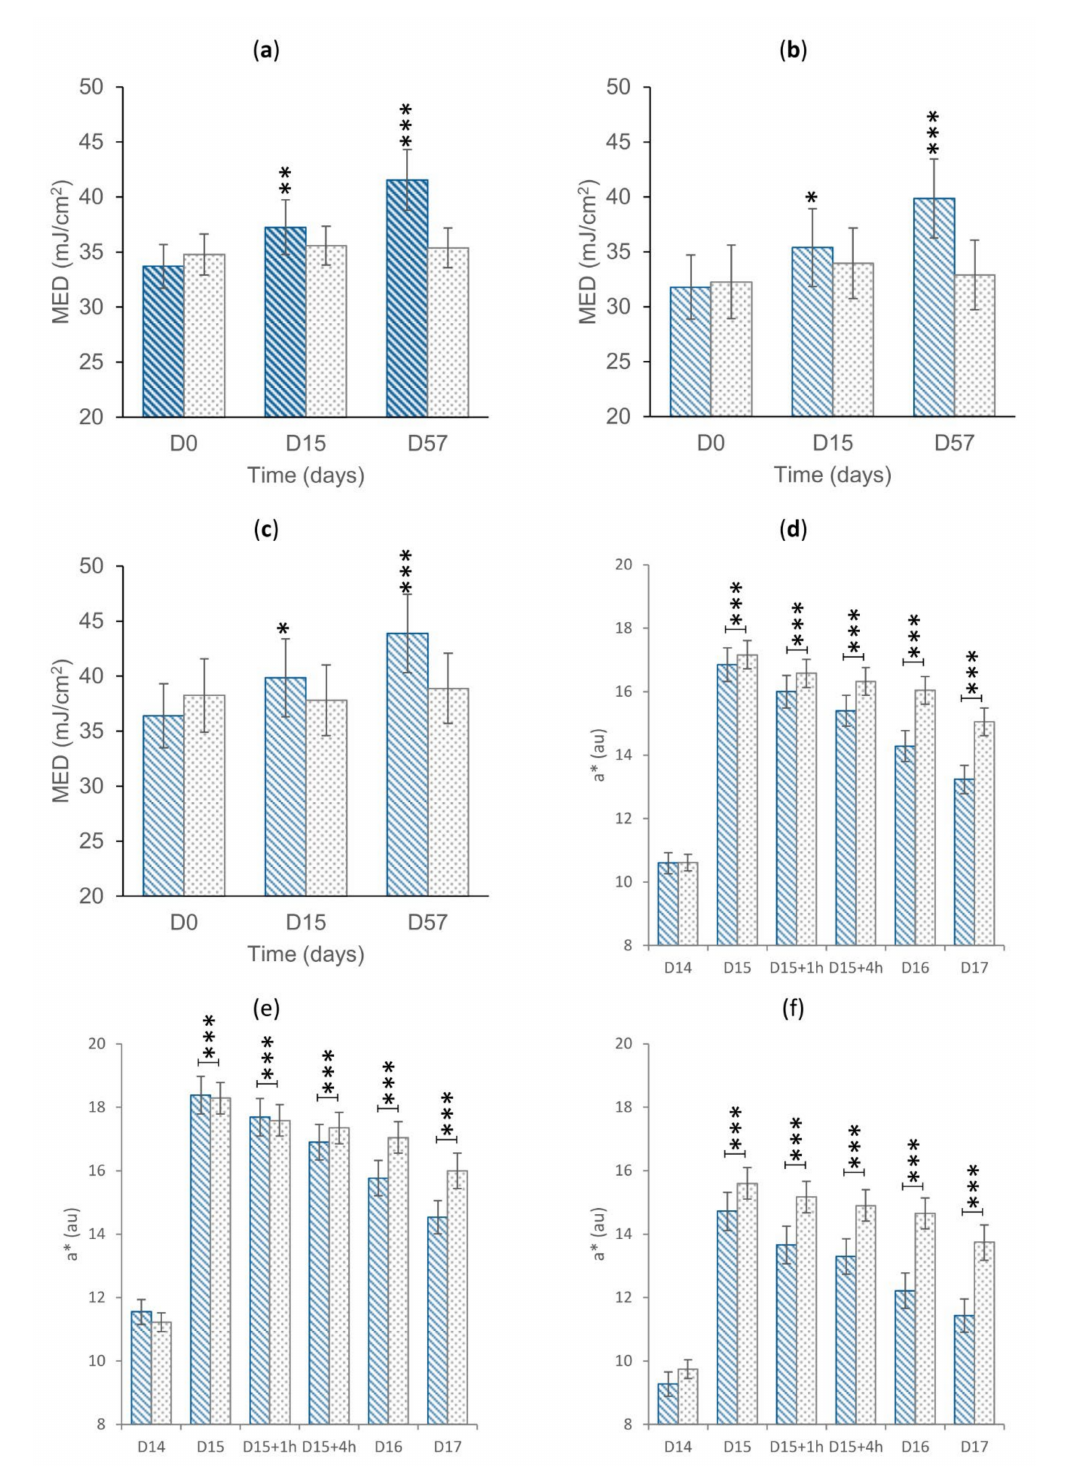
Figure 3. ( a ) MED in the overall treatment arm. ( b ) MED in the Asian treatment arm. ( c ) MED in the Caucasian treatment arm. Data are average ( ± standard error). ( d ) Skin redness in the overall treatment arm. ( e ) Skin redness in the Asian treatment arm. ( f ) Skin redness in the Caucasian treatment arm. The intragroup (graphs a – c ) and the intergroup (graphs d – f ) statistical analyses are reported above the bar as follows: * p < 0.05, ** p < 0.01, and *** p < 0.001. Legend. au, arbitrary units. D0, baseline. D15, follow-up visit after 14 days of product use; D15+1h, 1 h after the product intake at D15; D15+4h, 4 h after the product intake at D15; D16, 1 day after the D15 product intake; D17, 2 days after the D15 product intake; D57, follow-up visit after 56 days of product use.